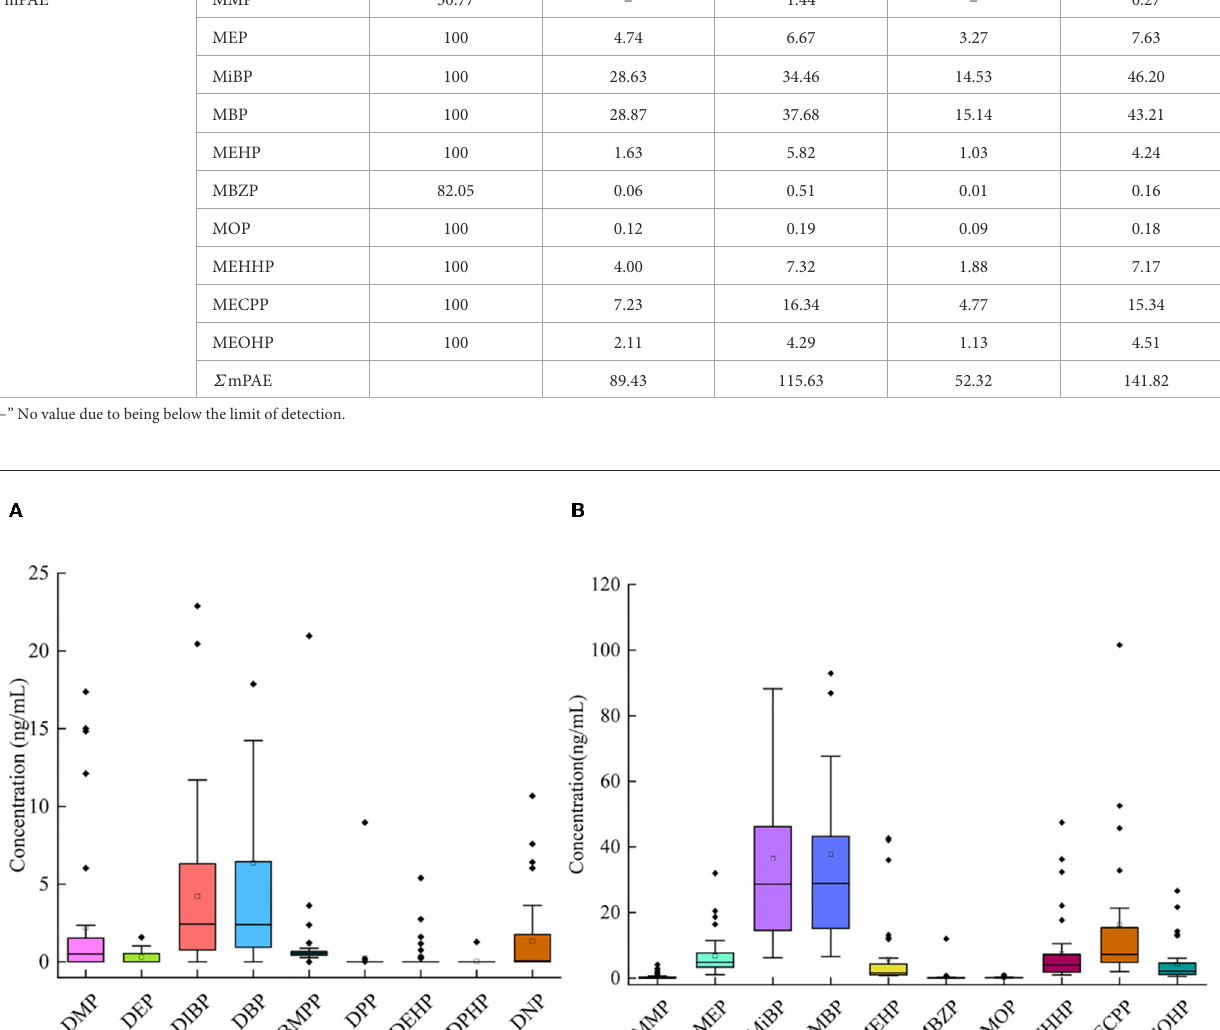
FrontiersinPublicHealth